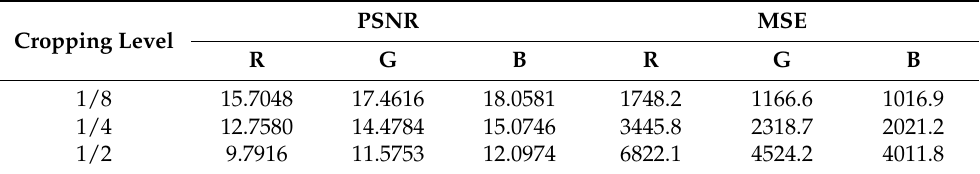
Table 10. Cropping attack Table 9. Noise attack analysis.